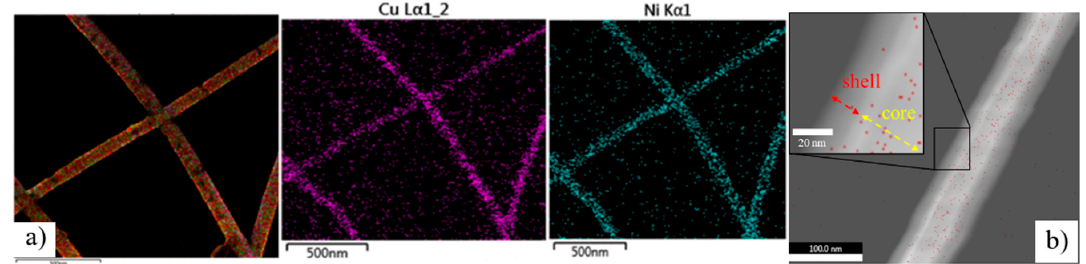
Figure 5. ( a ) EDS and ( b ) TEM images of the Cu–Ni nanowire network after plating.